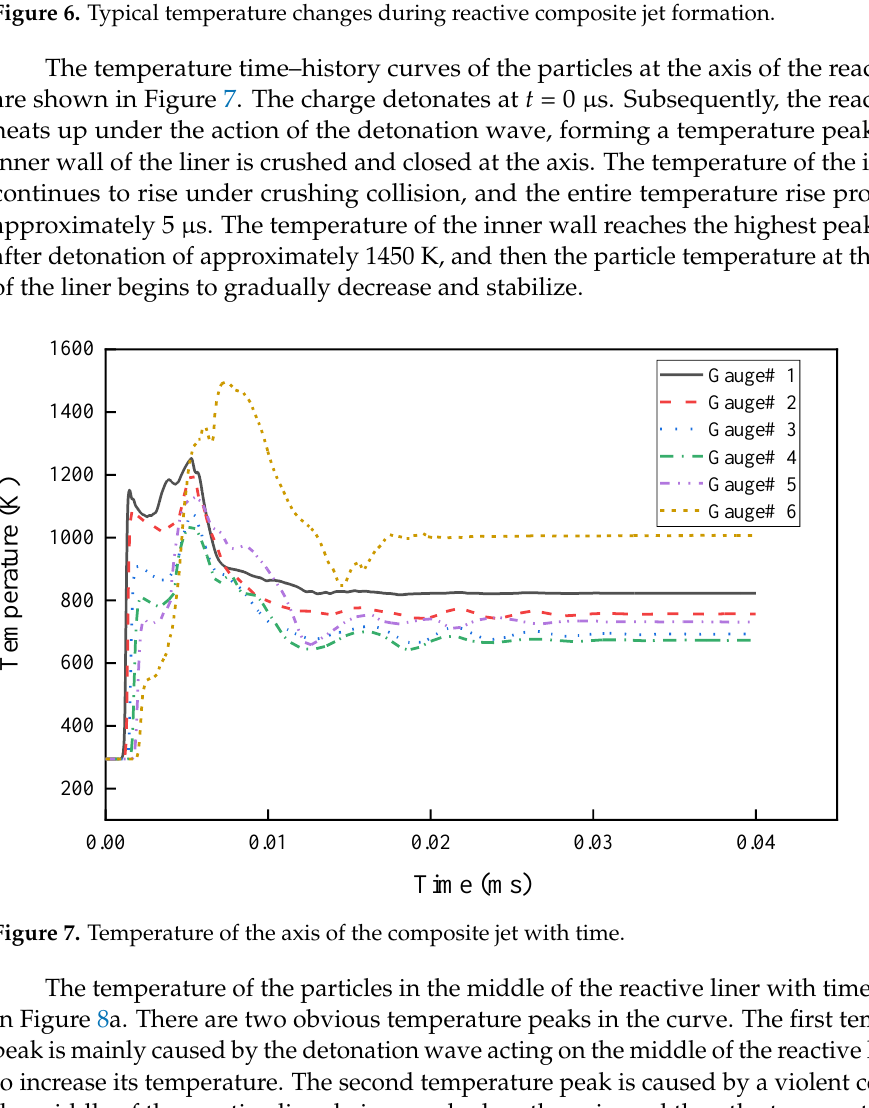
Figure 7. Temperature of the axis of the composite jet with time. The temperature of the particles in the middle of the reactive liner with time is shown in Figure 8a. There are two obvious temperature peaks in the curve. The first temperature peak is mainly caused by the detonation wave acting on the middle of the reactive liner form to increase its temperature. The second temperature peak is caused by a violent collision in the middle of the reactive liner being crushed on the axis, and then the temperature drops and tends to be stable. The temperature of the particles in the bottom of the reactive liner with time is shown in Figure 8b. Different from the top and middle particles of the reactive liner, since the reactive liner bottom cannot be crushed to form the reactive composite jet, the temperature at the bottom only rises at an instant under the action of detonation wave, and then the temperature decreases with time and tends to be stable.